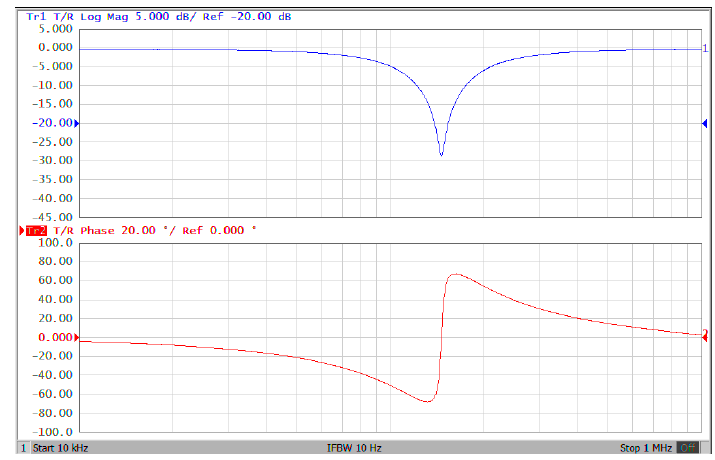
Figure 33. Experimentally observed gain and phase responses of the BR filter realized in case I.